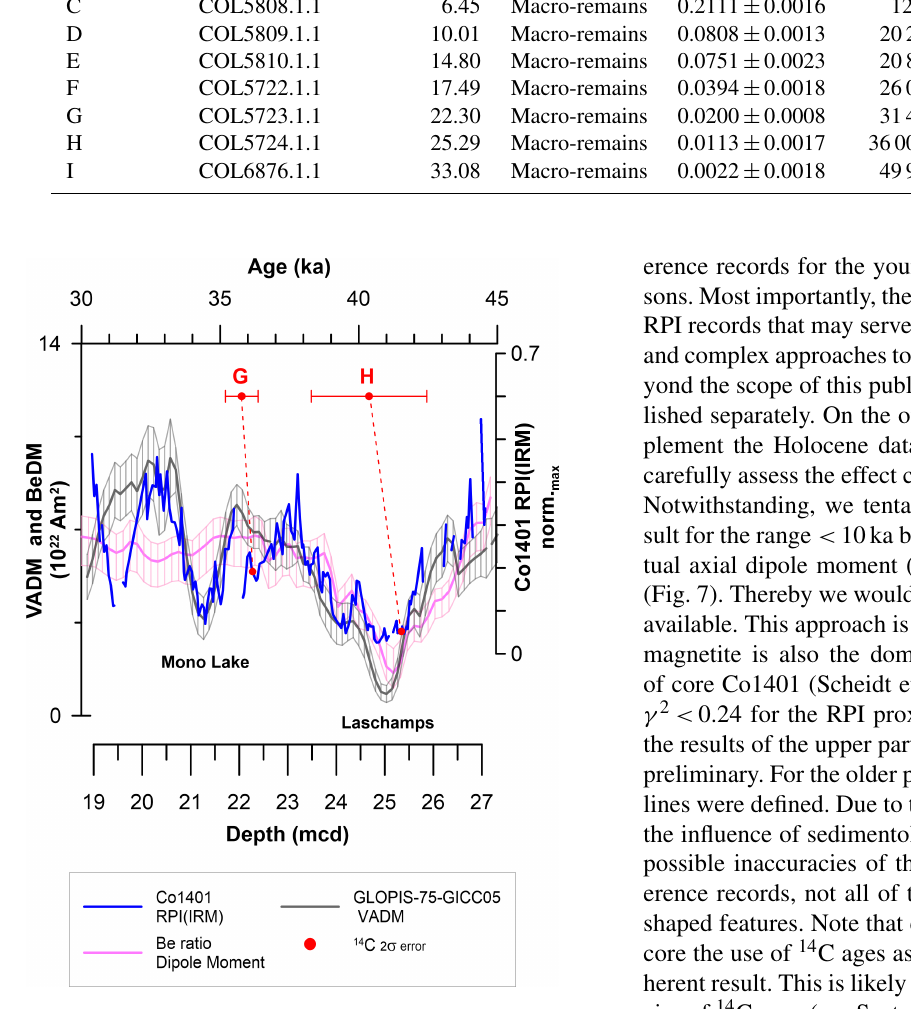
Figure 6. RPI(IRM) vs. depth of Co1401 (19–27mc.d.) compared to GLOPIS-75-GICC05 VADM vs. age and the Be ratio dipole mo- ment (BeDM) of Simon et al. (2020) vs. age (30–45ka). The 14 C ages H and G (Table 2) and the geomagnetic excursions Laschamps and Mono Lake are